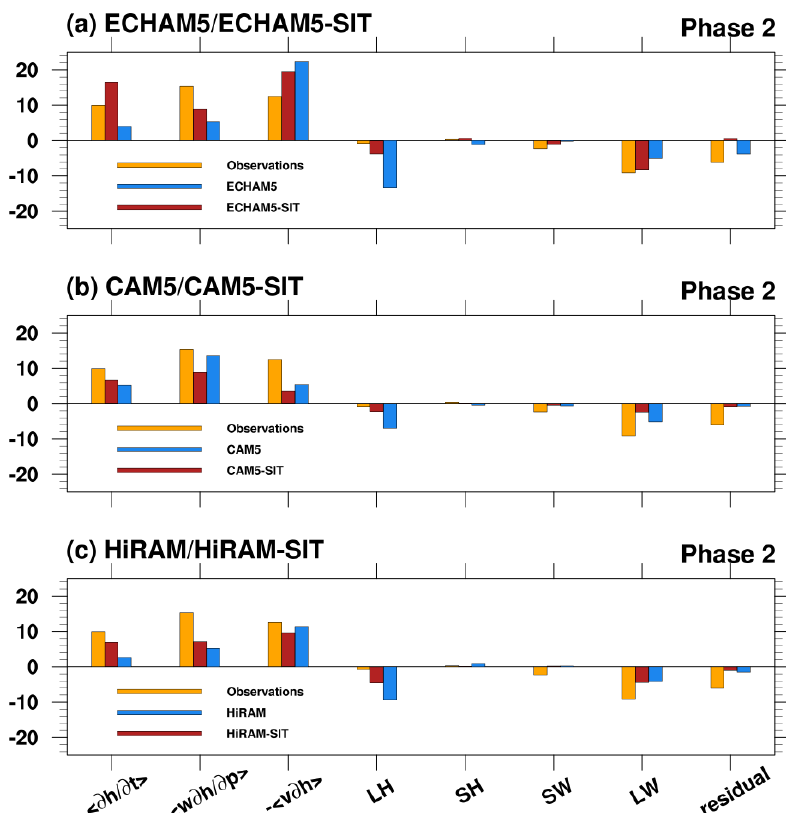
Figure 9. Model-simulated column-integrated MSE budget terms (Jkg − 1 s − 1 ) during phase 2 of the MJO. Black, red, and blue represent the data from the observations, Nordeng scheme simulations, and Tiedtke scheme simulations, respectively. The averaged domain is 10 ◦ S– 0 ◦ N/S, 120–150 ◦ E.